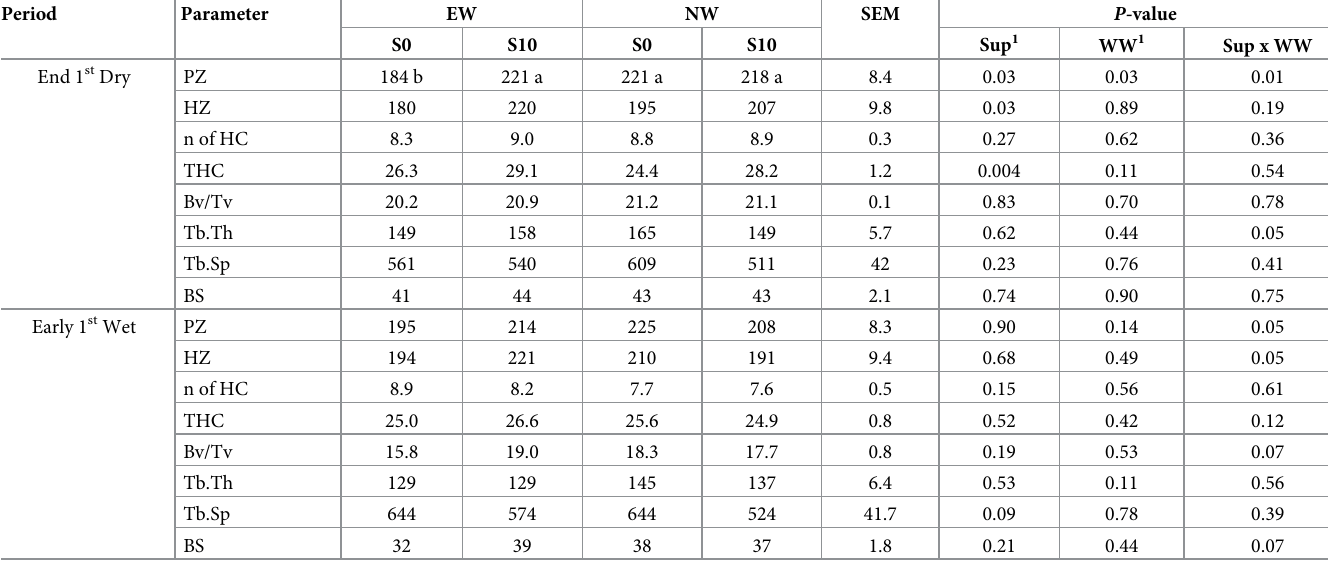
Table 4. Height of proliferative (PZ; μ m) and hypertrophic zone (HZ; μ m), number of hypertrophic chondrocytes (n of HC) per column (n/column), diameter ter- minal hypertrophic chondrocytes (THC; μ m), bone volume (Bv/Tv; %), trabecular separation (Tb.Th; μ m), trabecular thickness (Th.Sp; μ m) and bone surface area (BS; mm 2 ) of early (EW) and normally (NW) weaned crossbred Brahman heifers fed two different supplement treatments 1 during the first dry season 2,3 .